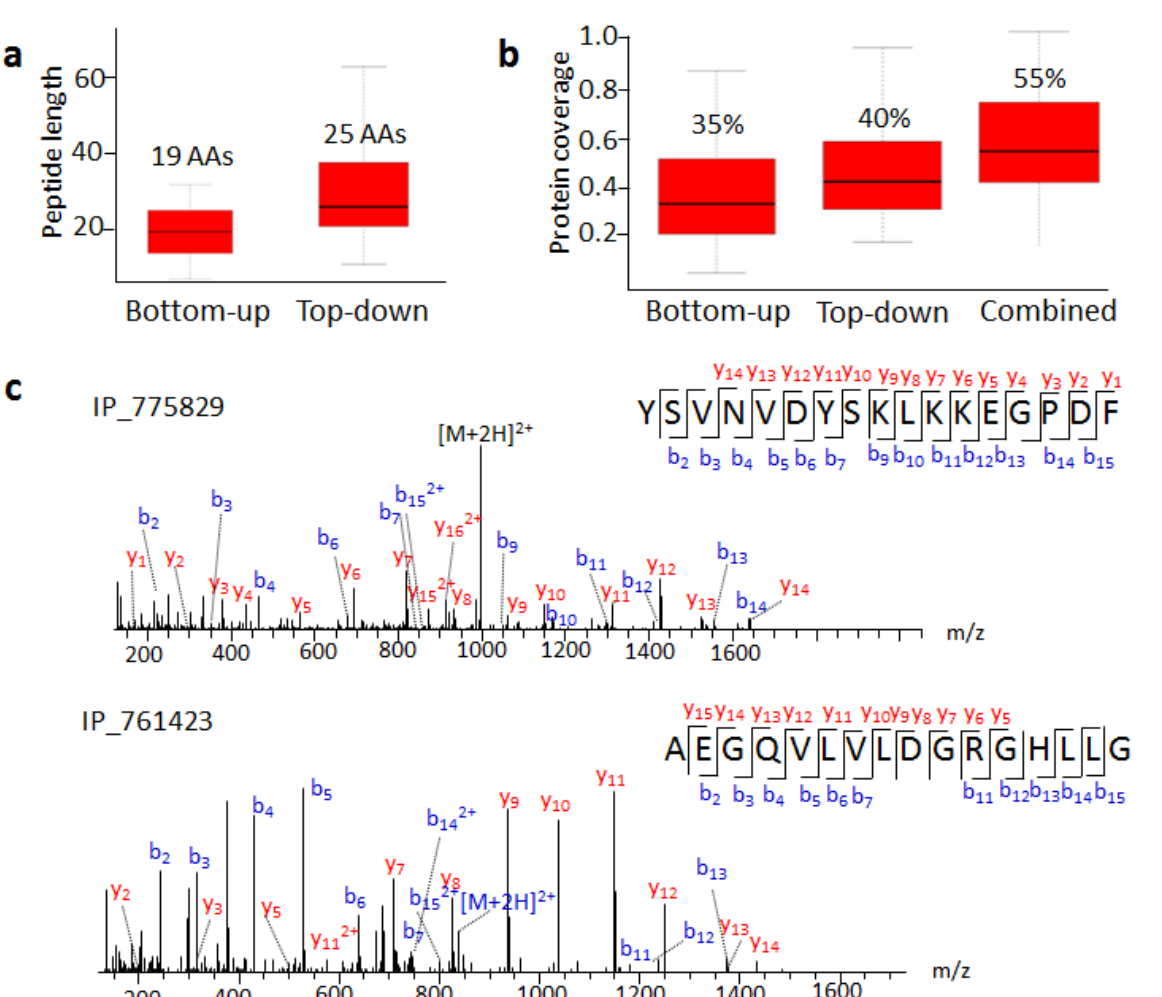
Figure 4. Top-down approach improves SEP identification. ( a ) Average lengths of peptides identified by bottom-up and top-down approaches. ( b ) SEP sequence coverage of bottom-up and top-down approaches. ( c ) MS/MS spectra of IP_775829 C-terminal and IP_761423 N-terminal peptides.